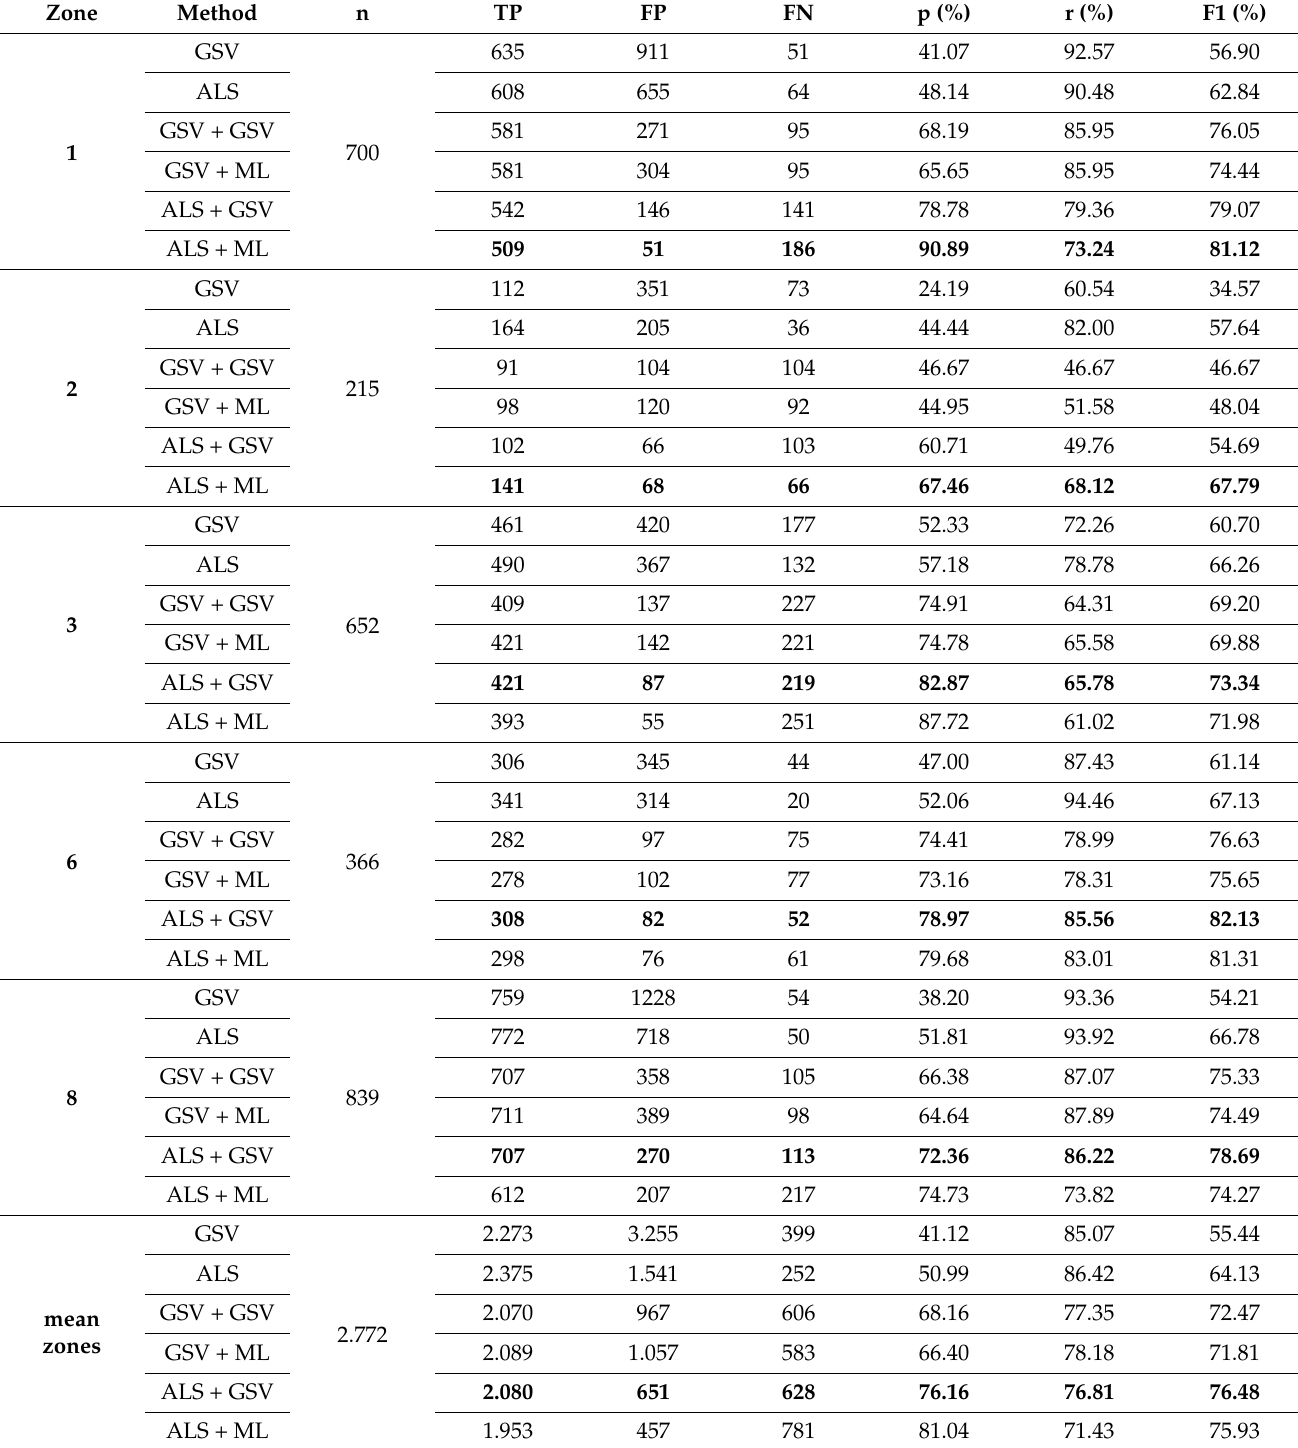
Table 1. Results obtained in the urban tree inventory for the different combinations of stages in the circles (only trafficable by vehicles) of the city of Pamplona (n is the official number of trees, TP is the true positives detected, FP is the false positives detected, FN is the false negatives detected, p is the precision, r is the recall, and F1 is the overall precision). The highest rated combination of methods is identified in